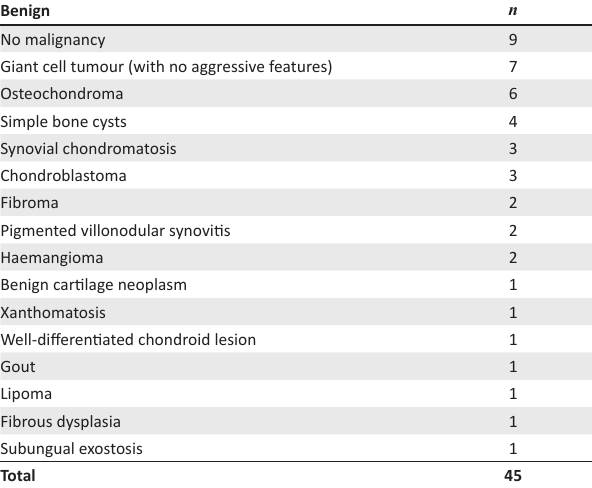
TABLE 2: Summary of histologically benign lesions ( n = 45). Benign n